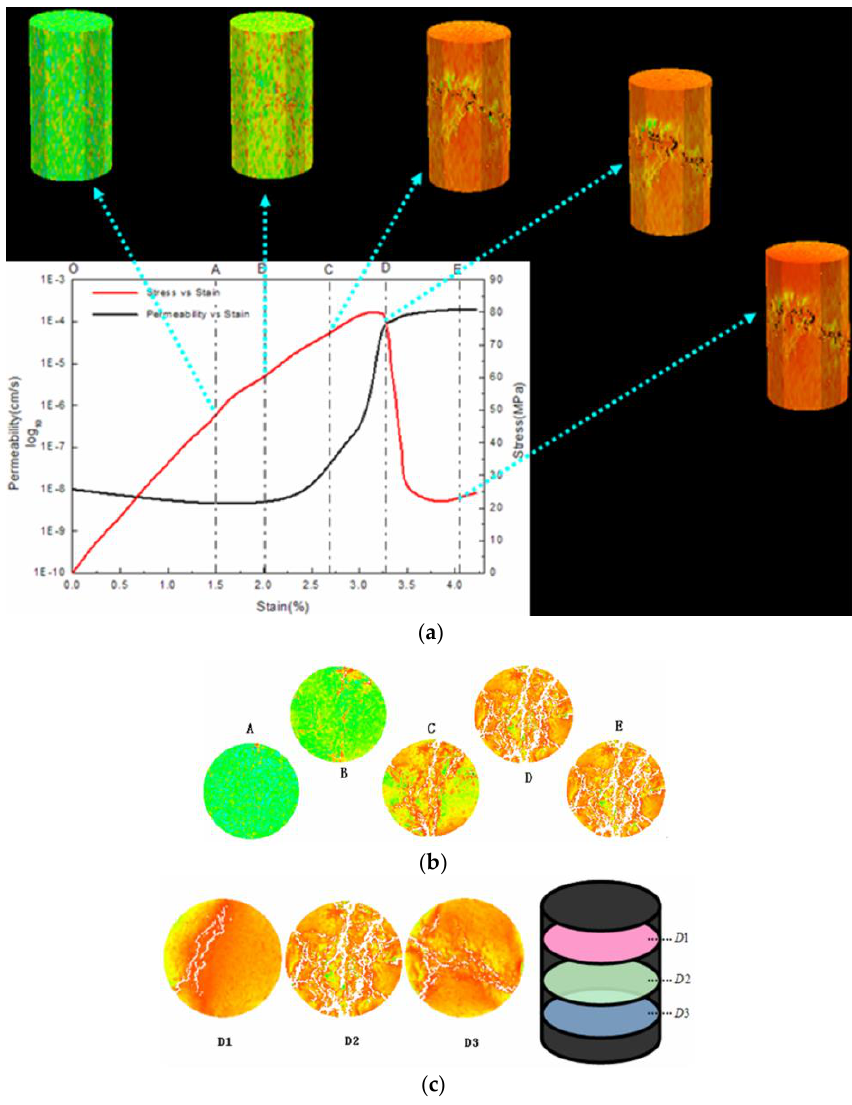
Figure 4. Illustration of high-performance fine modelling on a rock sample stress–strain process using statistical meso-damage Finite Element Method [41]: ( a ) Simulated permeability evolution along with stress–strain process; ( b ) Progress cracking states on the middle cross-section at five typical moments; ( c ) Cracking states on three typical cross-sections at the peak-stress moment.